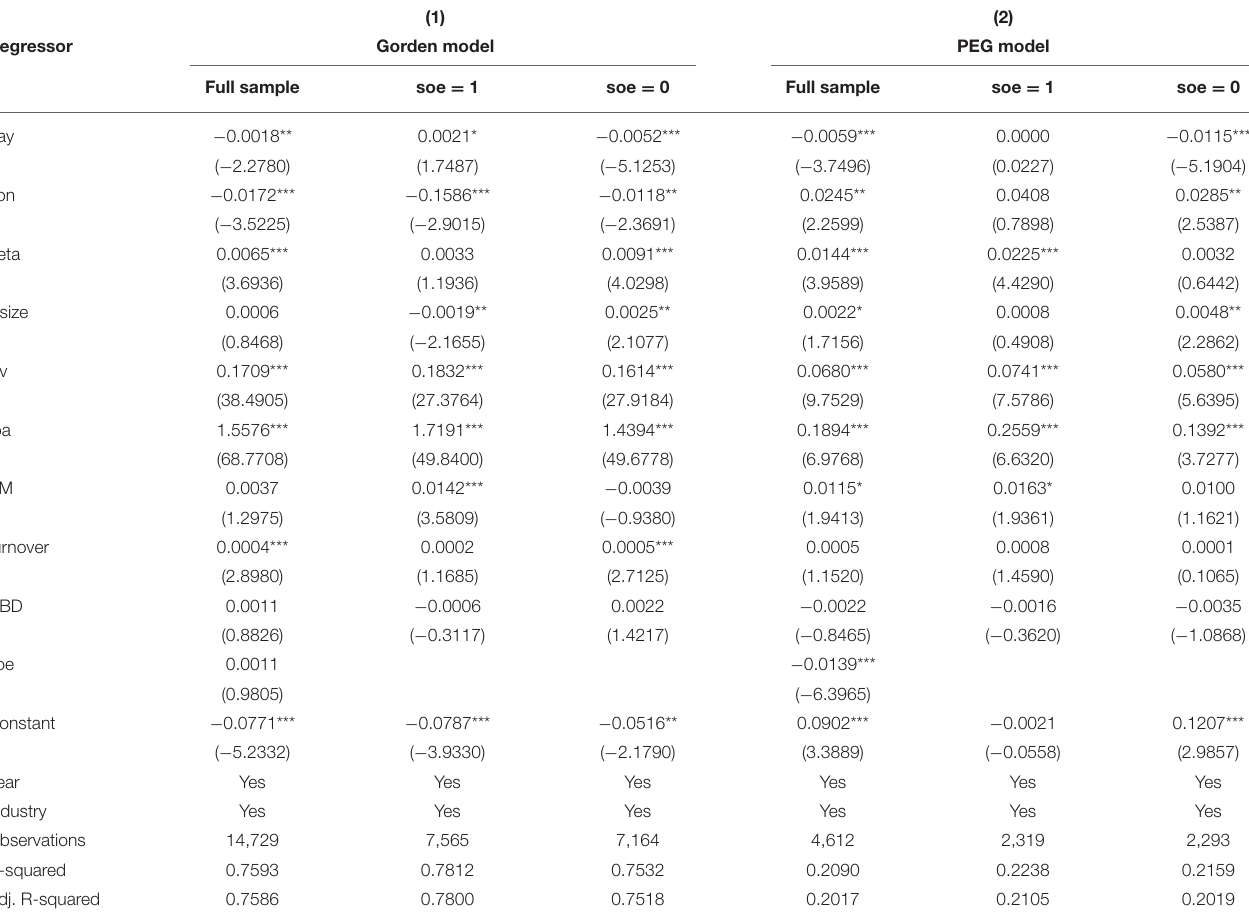
TABLE 10 | Considering the effect of executive